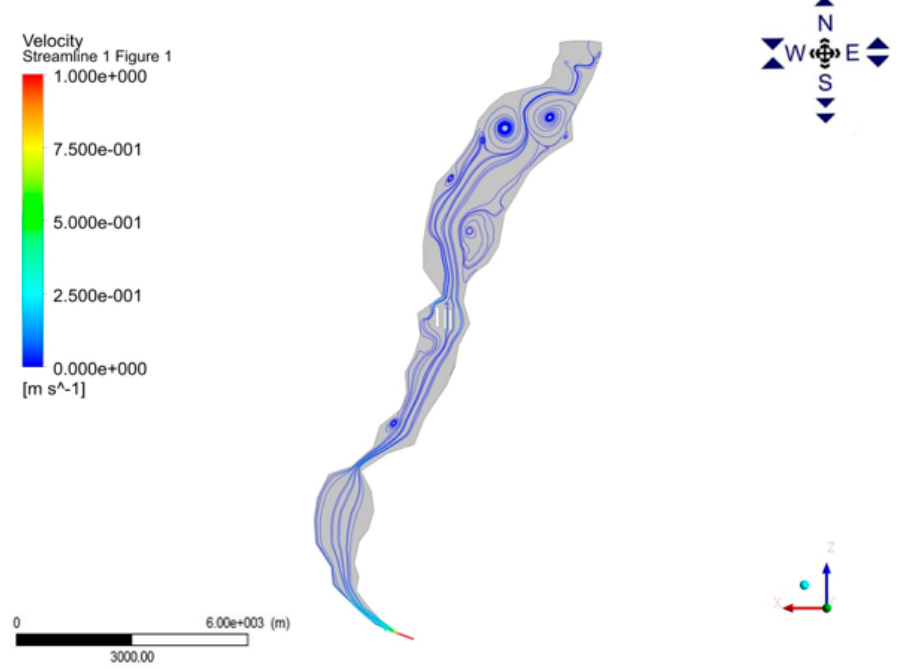
Figure 12. Surface velocity stream lines in the Sulejów Reservoir in October 2015 [2].